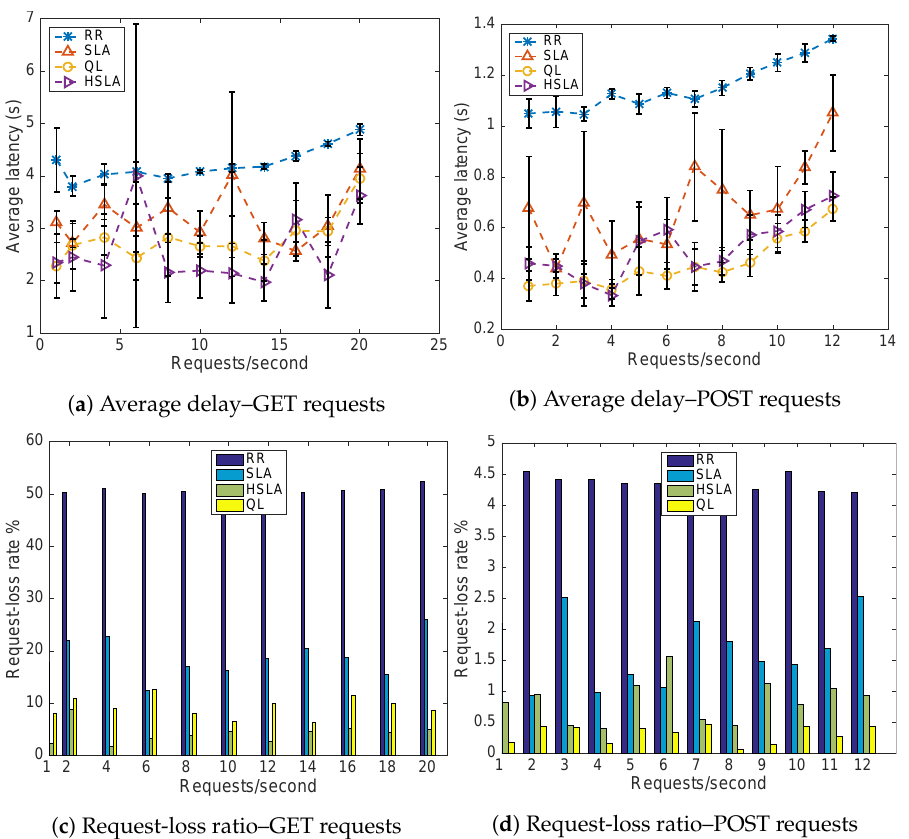
Figure 5. Performance